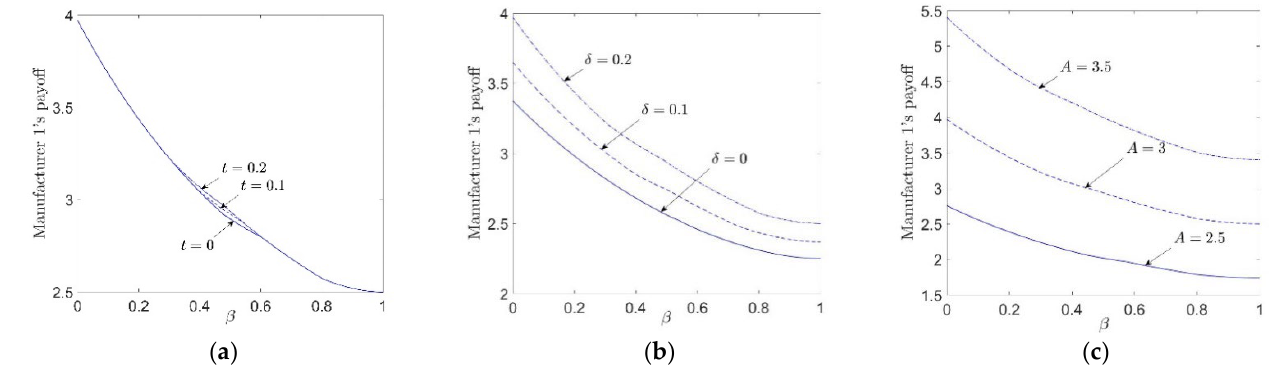
and ( a ) ( b ) ( c ) 𝛽𝛽 𝑡𝑡 𝛿𝛿 𝐴𝐴